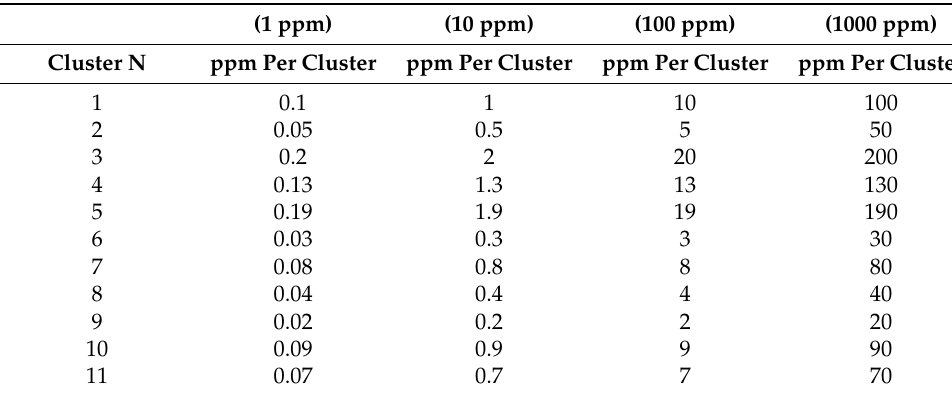
Figure 10. Fluences—photon and electron vs. ppm contamination PO4 group. Table 4. Cluster configuration vs. PO4 group ppm.